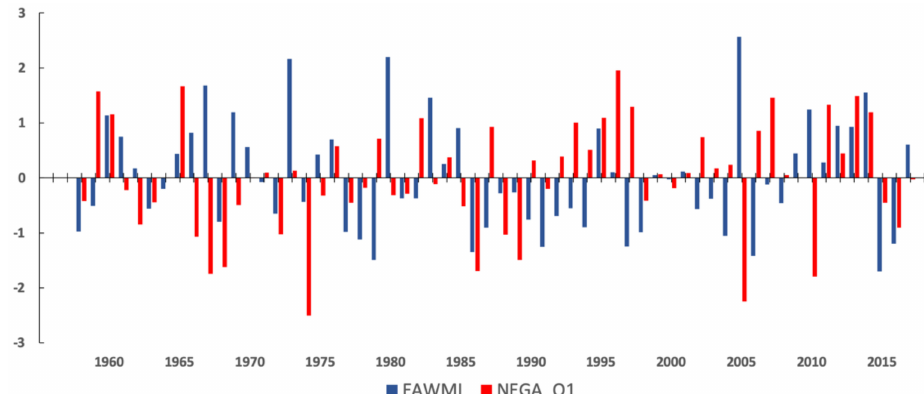
Figure 3. Time series of the standardized December East Asian Winter Monsoon Index EAWMI ( I Sun ) during 1958 − 2017 and the negative values of Q 1 .